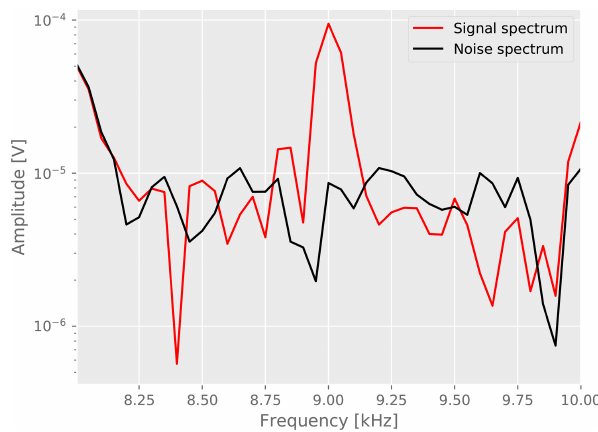
Figure 5. Frequency spectra for noise and signal windows for a burst measurement during series 19 at